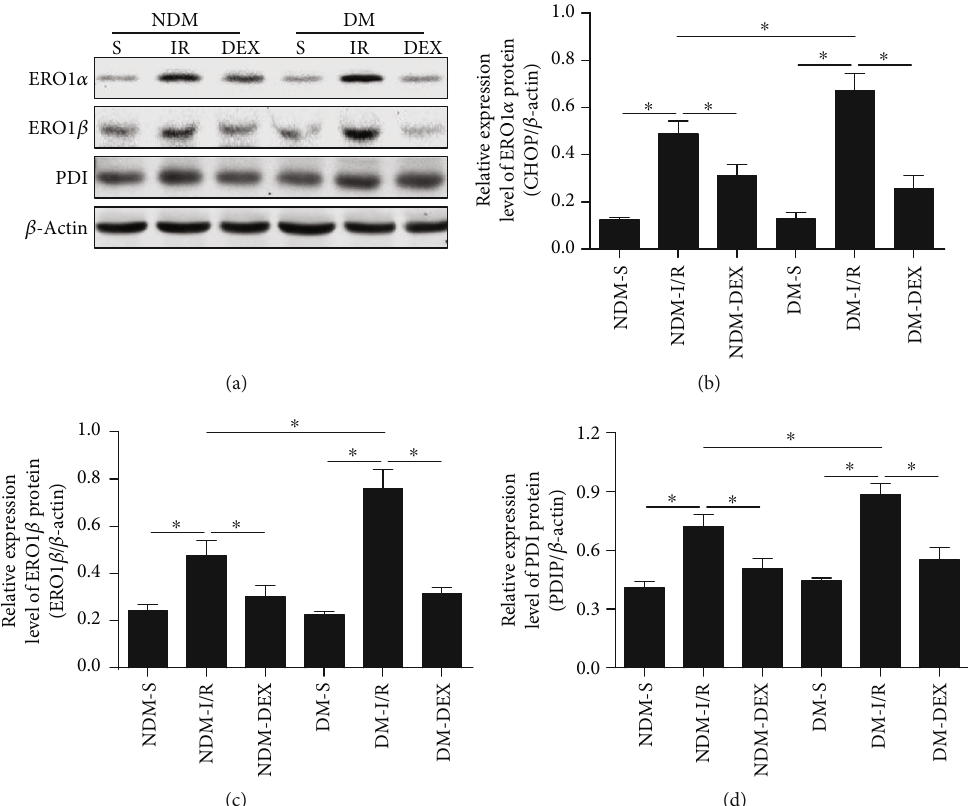
Figure 5: DEX reduces ERO1 α , ERO1 β , and PDI protein expression in myocardial tissue. ERO1 α , ERO1 β , and PDI protein expressions in the myocardium were detected by western blot. (a) Western blot. (b) The bar graph of ERO1 α protein expression. (c) The bar graph of ERO1 β protein expression. (d) The bar graph of PDI protein expression. All results are expressed as the mean ± SD . ∗ P < 0 : 05 between each group.